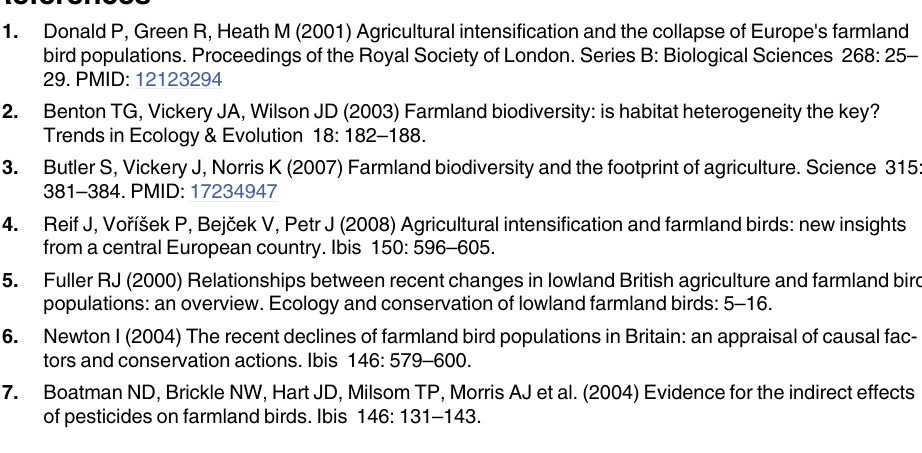
S1 Table. Ecological or functional categorizations and encounter rate (no of individuals per point) of all species recorded from e-waste exposed, surrounding, and reference sites in Guangdong, China. Data on three key ecological or functional traits (i.e. habitat prefer- ence, dietary guild and migratory status) were primarily collated from Zhao (2001) and Zhang et al. (2011). a Habitat preference codes: “ artificial marshland or wetland (AW) ” ; “ aquatic ponds and paddy (AP) ” ; “ woodland specialist (WS) ” ; “ edge-tolerant woodland species (EWS) ” ; “ non-forest dependent species (e.g., plantation and orchard; NFS) ” ; “ generalist (G) ” ; “ aerial species (A) ” ; “ grassland and shrub users (GSU) ” and “ open-habitat species (OS) ” . b Die- tary guild codes: “ carnivore (CA) ” , “ arboreal foliage glean insectivore (AI) ” , “ arboreal foliage glean insectivore-frugivore (AIF) ” , “ sallying insectivore (SI) ” , “ terrestrial insectivore (TI) ” , “ miscellaneous insectivore (MI) ” , “ terrestrial insectivore-frugivore (TIF) ” , “ arboreal frugivore (AF) ” , “ terrestrial granivores (TG) ” , “ miscellaneous insectivore-piscivore (MIP) ” , and “ aquatic invertebrate (AQI) ” . c Migrations status codes: Permanent resident (R), Winter visitor (W), Summer visitor (S), and Passage migrant